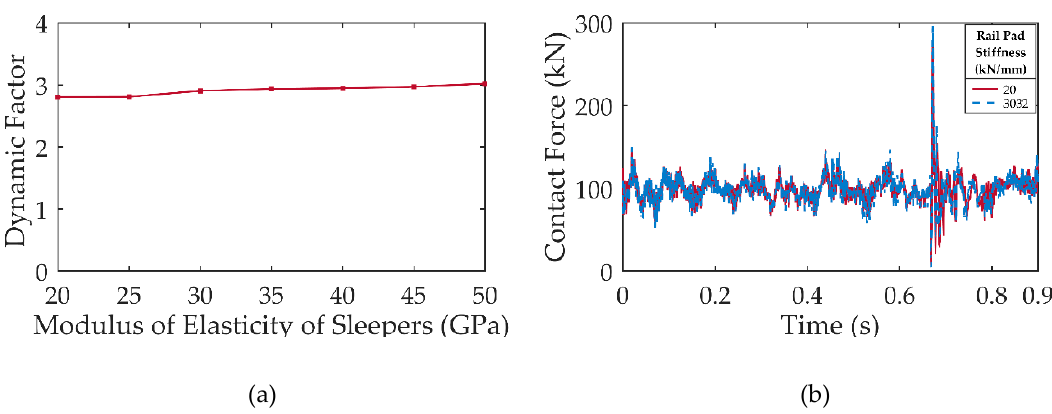
Figure 12. Effect of modulus: ( a ) Variations in dynamic factor which correspond to different moduli of elasticity; ( b ) contact forces for minimum and maximum modulus of elasticity.